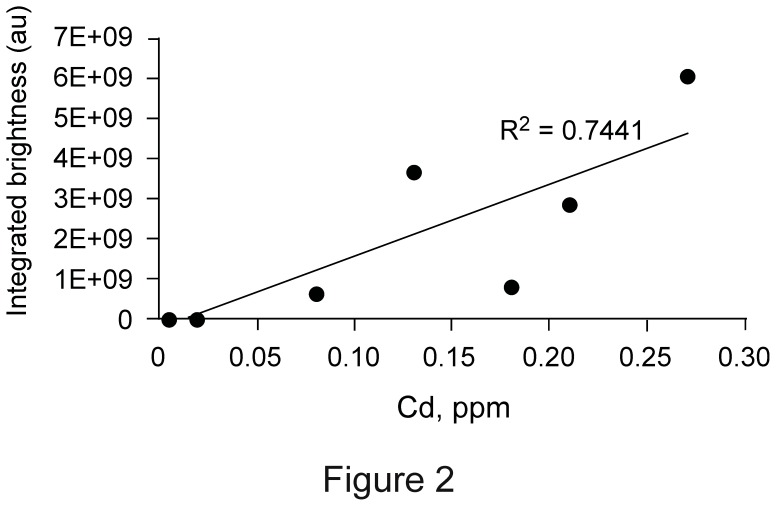
Comparison of Qdot content as assessed by integrated spot brightness with cadmium content by ICP-MS.Data were from
Table 2
.